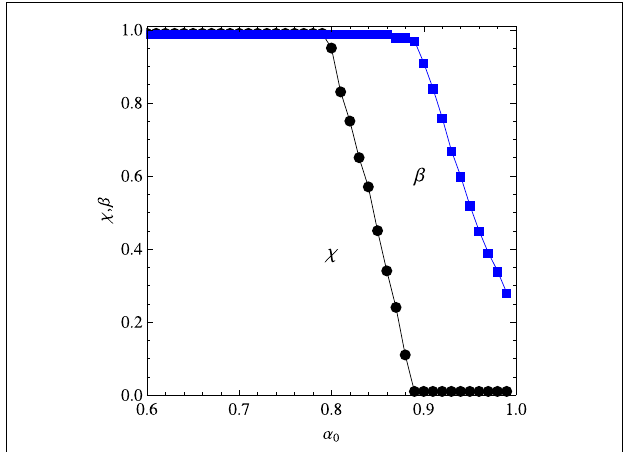
FIGURE 8 | Knowledge development for the model parameters that best fit the results of the mutual exclusivity experiments summarized in Figures 5, 6 in the case the late phase of the training process comprises 6 repetitions of each word. The symbol colors follow the convention used in those figures, i.e., the blue symbols represent the confidence on association ( w 1 , o 1 ) , the red symbols on association ( w 1 , o 7 ) , the green symbols on